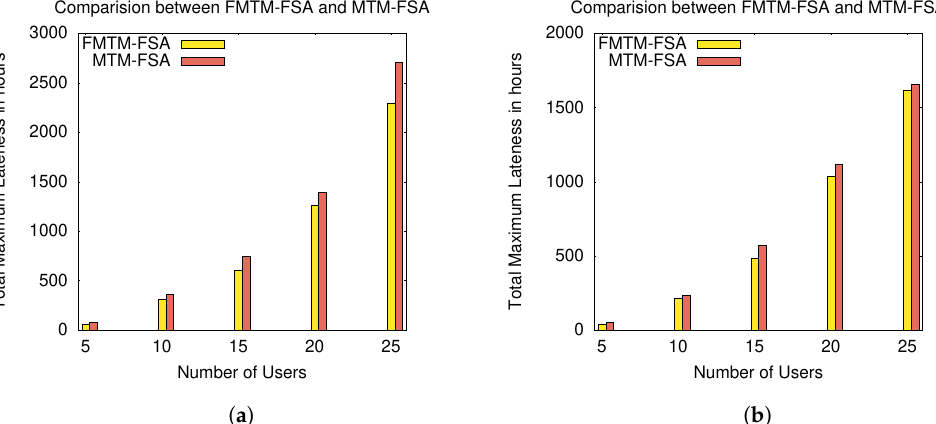
Figure 11. Comparison of FMTM-FSA and MTM-FSA based on lateness for the normal distribution (ND) and random distribution (RD) cases: ( a ) comparing FMTM-FSA and MTM-FSA (ND case) and ( b ) comparing FMTM-FSA and MTM-FSA (RD case).